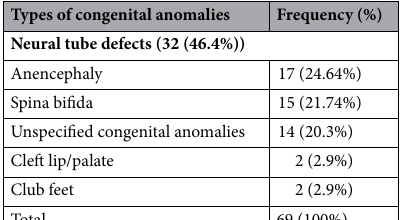
Types of congenital anomalies Frequency (%) Neural tube defects (32